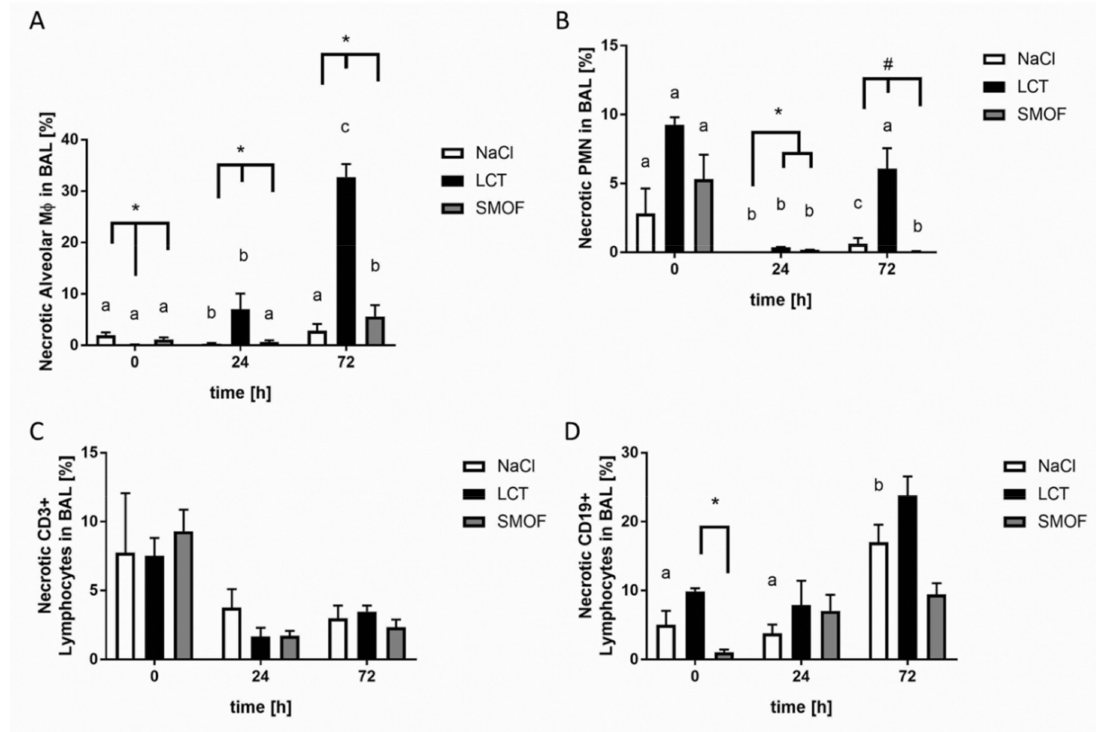
Figure 4. Analysis of necrosis in LPS-induced acute respiratory distress syndrome. ( A ): Assessment of necrotic alveolar M φ -type cells revealed that mice that received LCT infusions significantly di ff